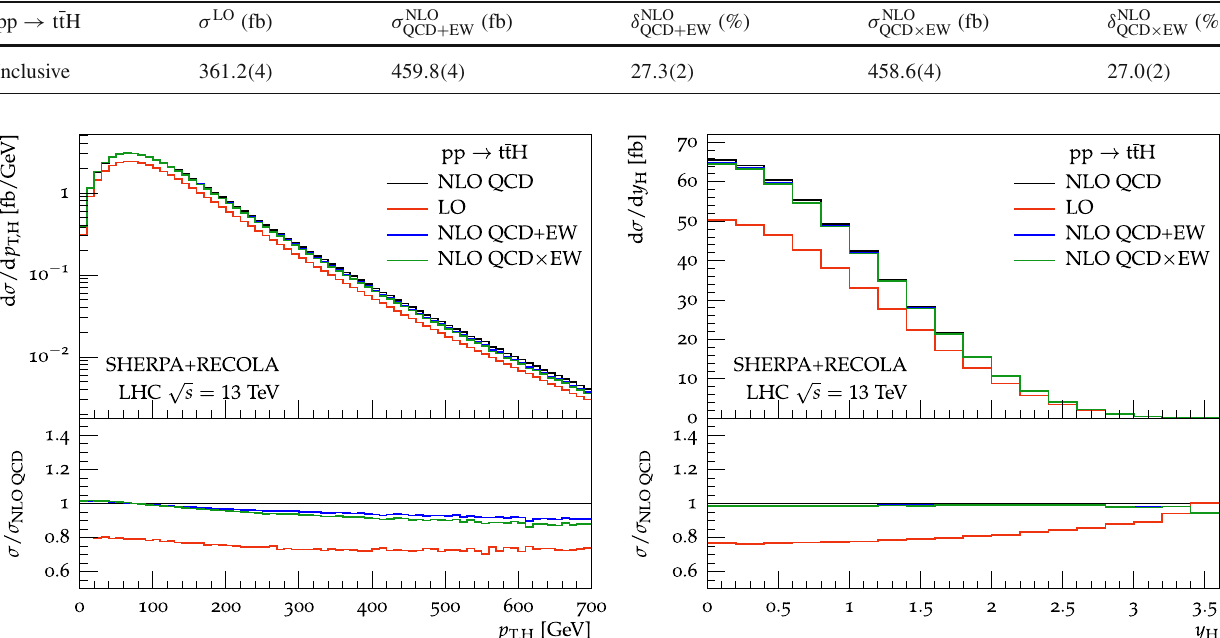
√ s = 13TeV for pp → t ¯ tH at the LHC: transverse-momentum distribution ( left ) and